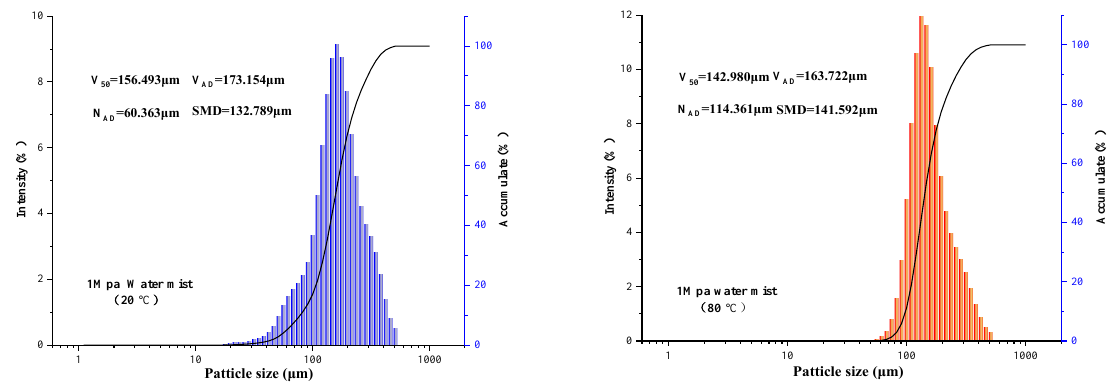
◦ C and 80 ◦ C water mist at 1 MPa.